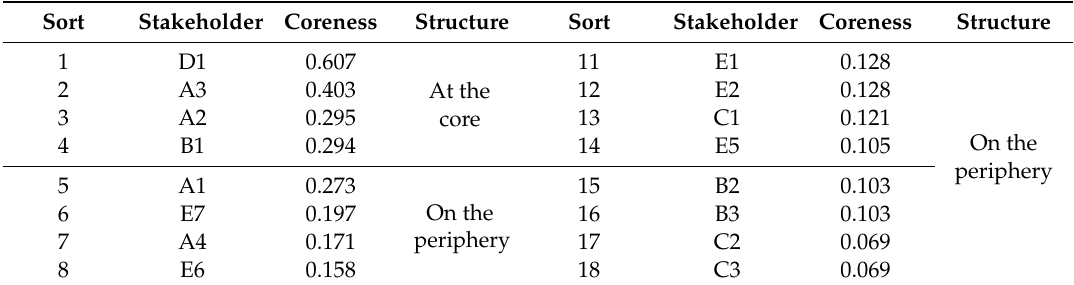
Table 3. The “core—periphery” Structure Analysis of ERC Network.